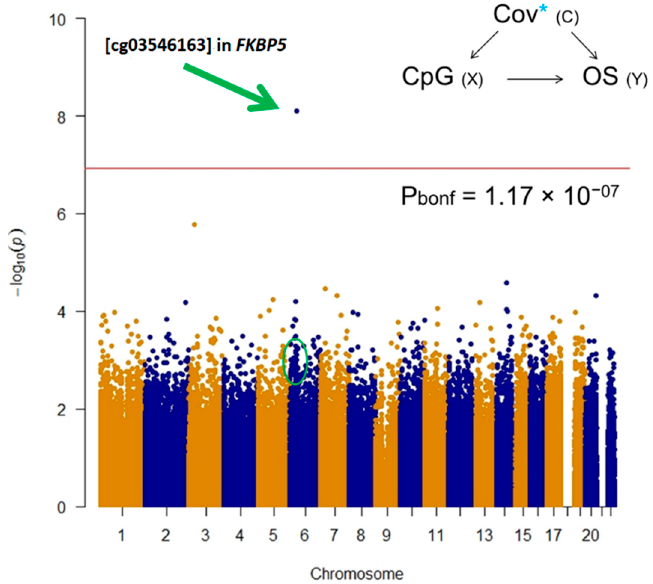
Figure 1. Manhattan plot for epigenome-wide association study (EWAS) test on 450k single CpGs. Overall survival was used as dependent variable considering 12 months as cut-off adjusting for age, gender, histological subtype, asbestos exposure, WBCs estimation, population stratification, and technical variability. Bonferroni post hoc line highlights statistically significant differences on OS at single CpG level.